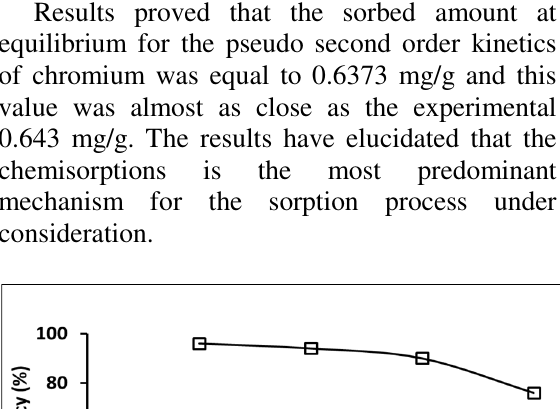
Results proved that the sorbed amount at equilibrium for the pseudo second order kinetics of chromium was equal to 0.6373 mg/g and this